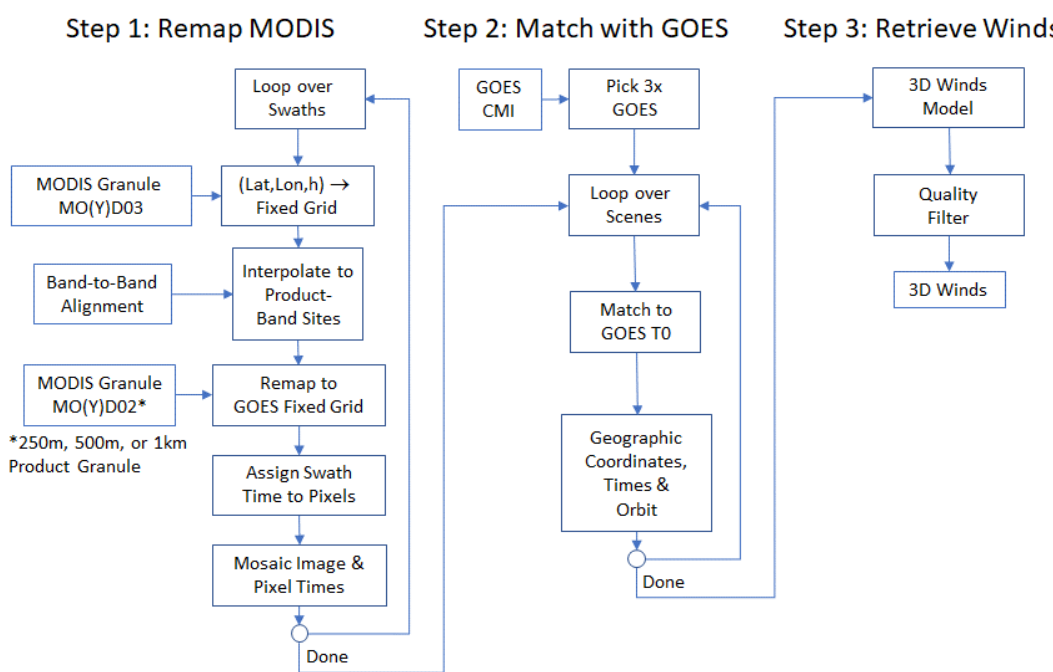
Figure 1. Creation of a 3D-winds dataset is a three-step process. Step 1 remaps a moderate resolution imaging spectroradiometer (MODIS) L1b granule into the fixed-grid projection of the advanced baseline imager (ABI). Step 2 matches features common to a triplet of GOES cloud and moisture imagery (CMI) or radiances and the remapped MODIS granule to measure disparities between apparent geographical positions, which are affected by both atmospheric motion and parallax. Step 3 interprets the observed disparities as atmospheric motion vectors (AMVs) with vertical height assignments.